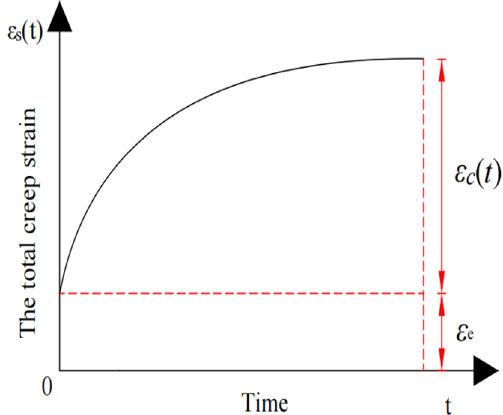
Figure 2. The total creep strain diagram.